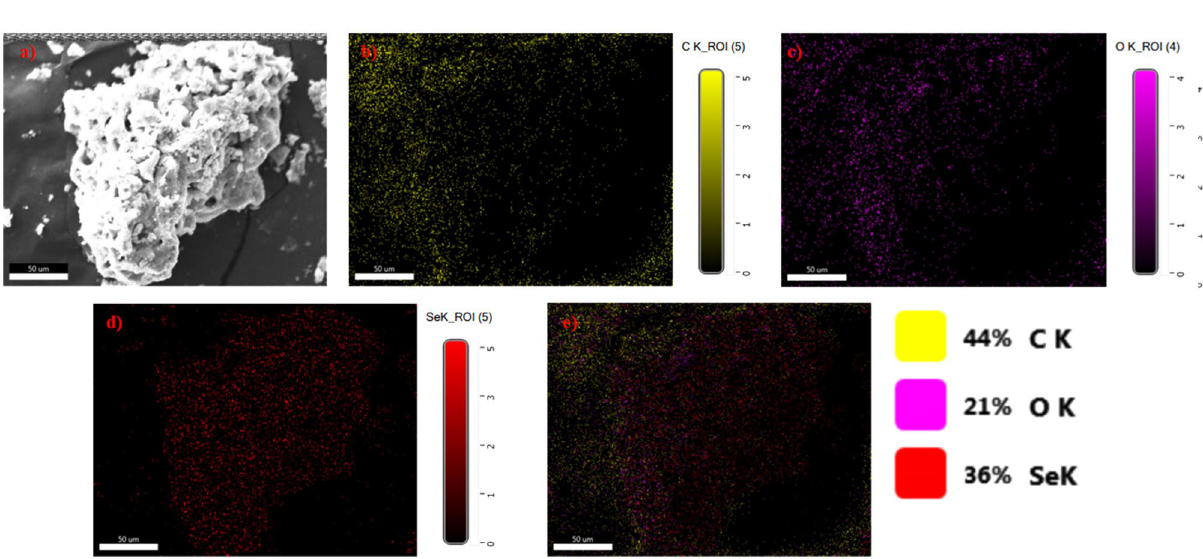
Figure 4. Rapid synthesized SeNPs FE-SEM elemental mapping analysis ( a ) original FE-SEM image, ( b ) carbon element, ( c ) oxygen element, ( d ) Selenium element and ( e ) all element combines with original FE-SEM image.